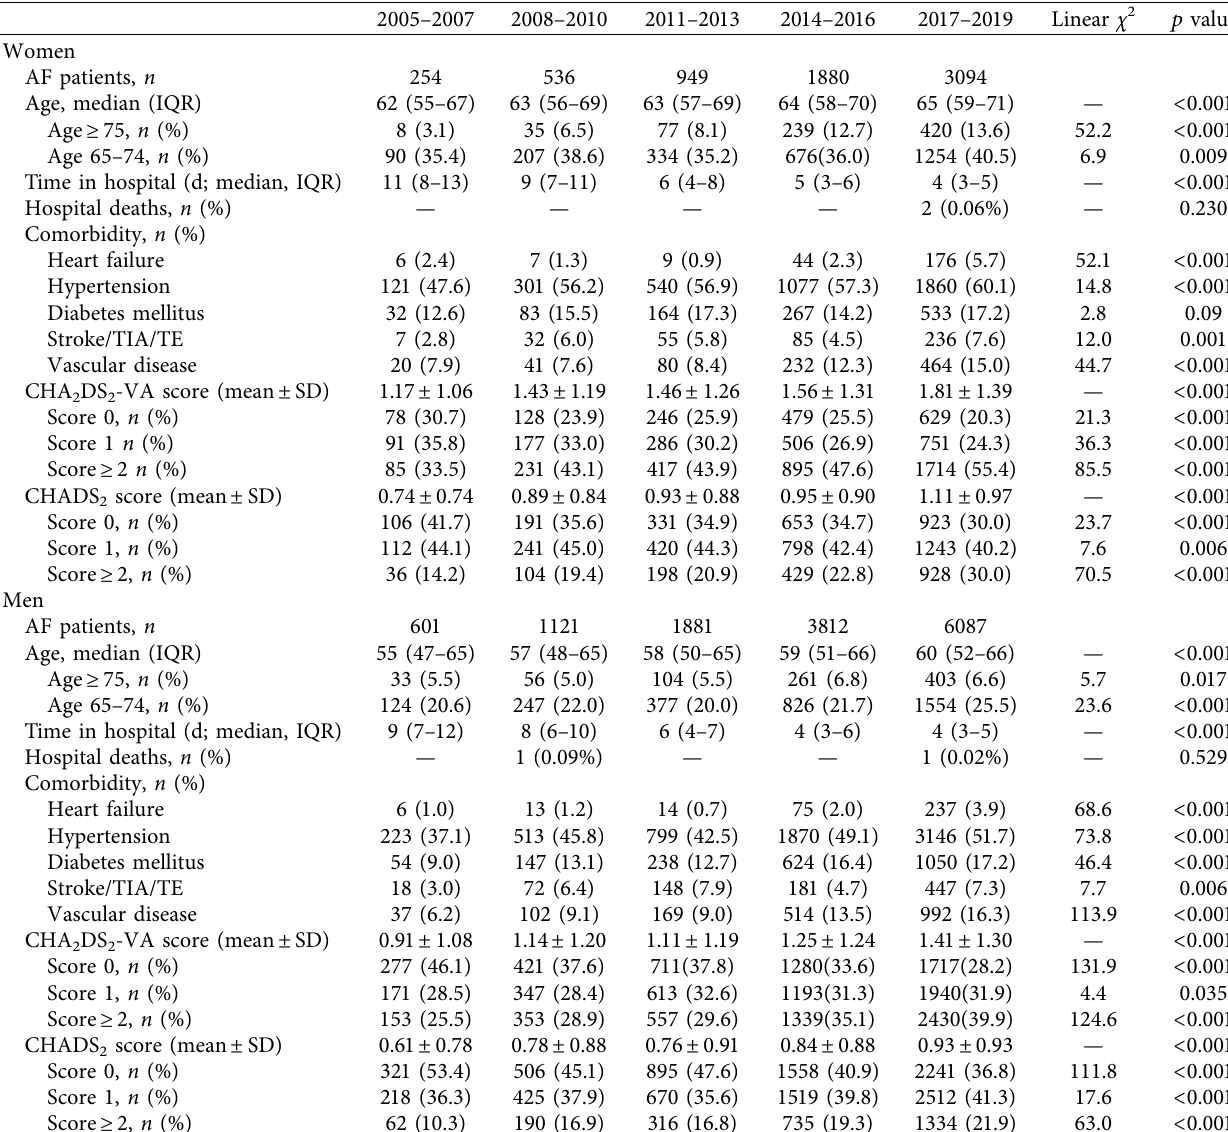
Table 2: Temporal trends in clinical features of women and